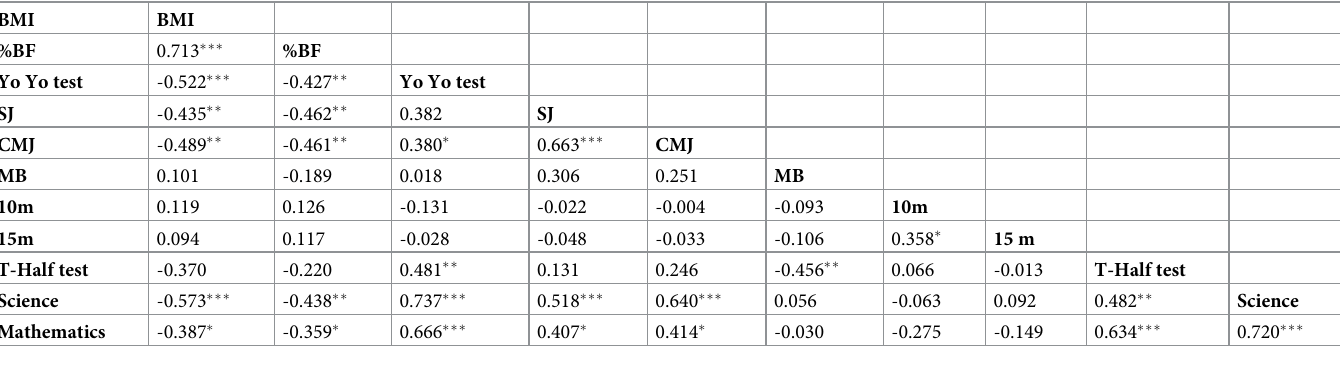
Table 2. Correlation matrix for measure of academic and physical